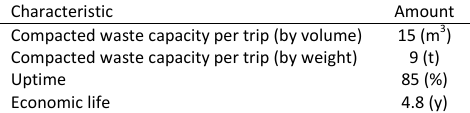
Table 4: Characterization of SWCTT vehicles Table 4. Characterization of SWCTT